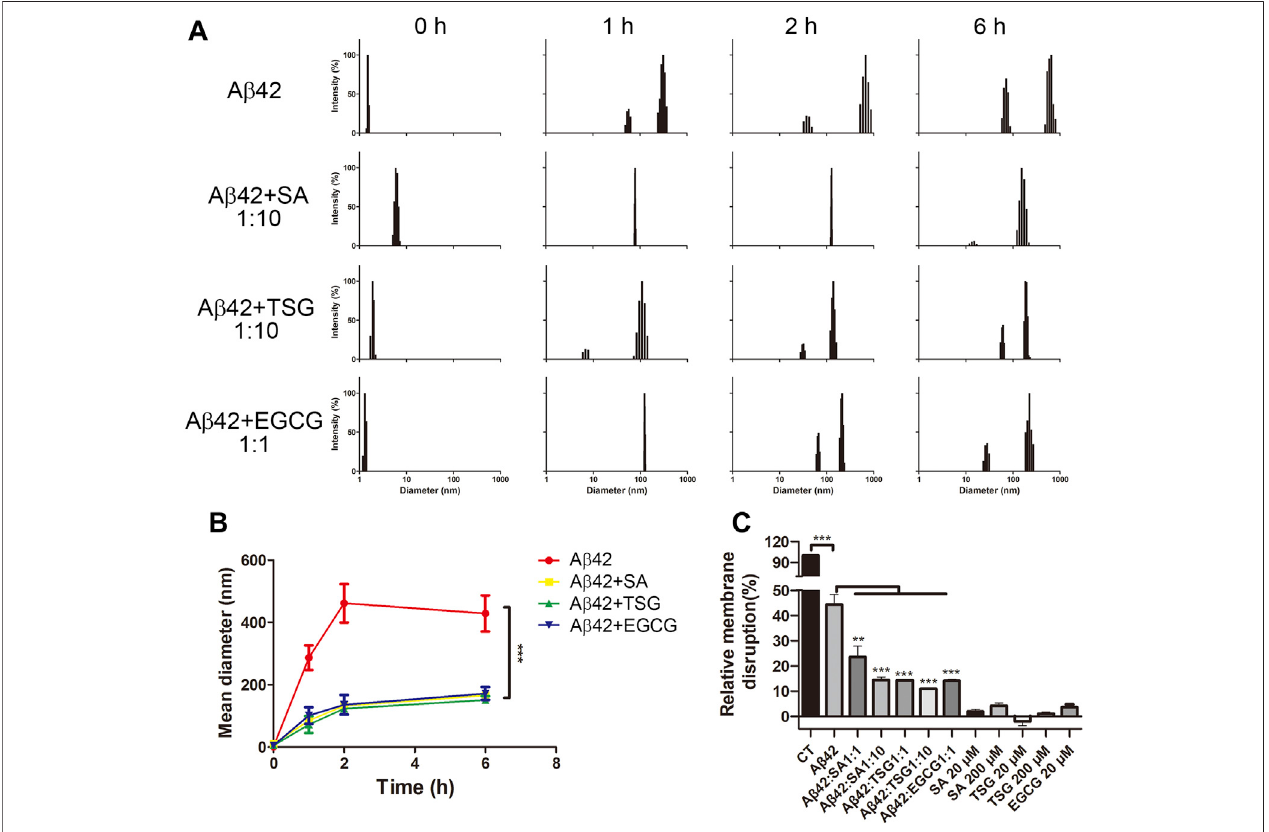
FIGURE 4 | Effects of EGCG, SA and TSG on the partial size distribution during A β 42 aggregation and on membrane disruption caused by A β 42 aggregates. (A) Dynamiclightscatteringanalysisofdifferentgroups; (B) Meandiameterchangesofdifferentgroups; (C) EffectsofEGCG, SAand TSGonmembrane disruptioncaused by A β 42 aggregates. **p < 0.01, ***p < 0.001.